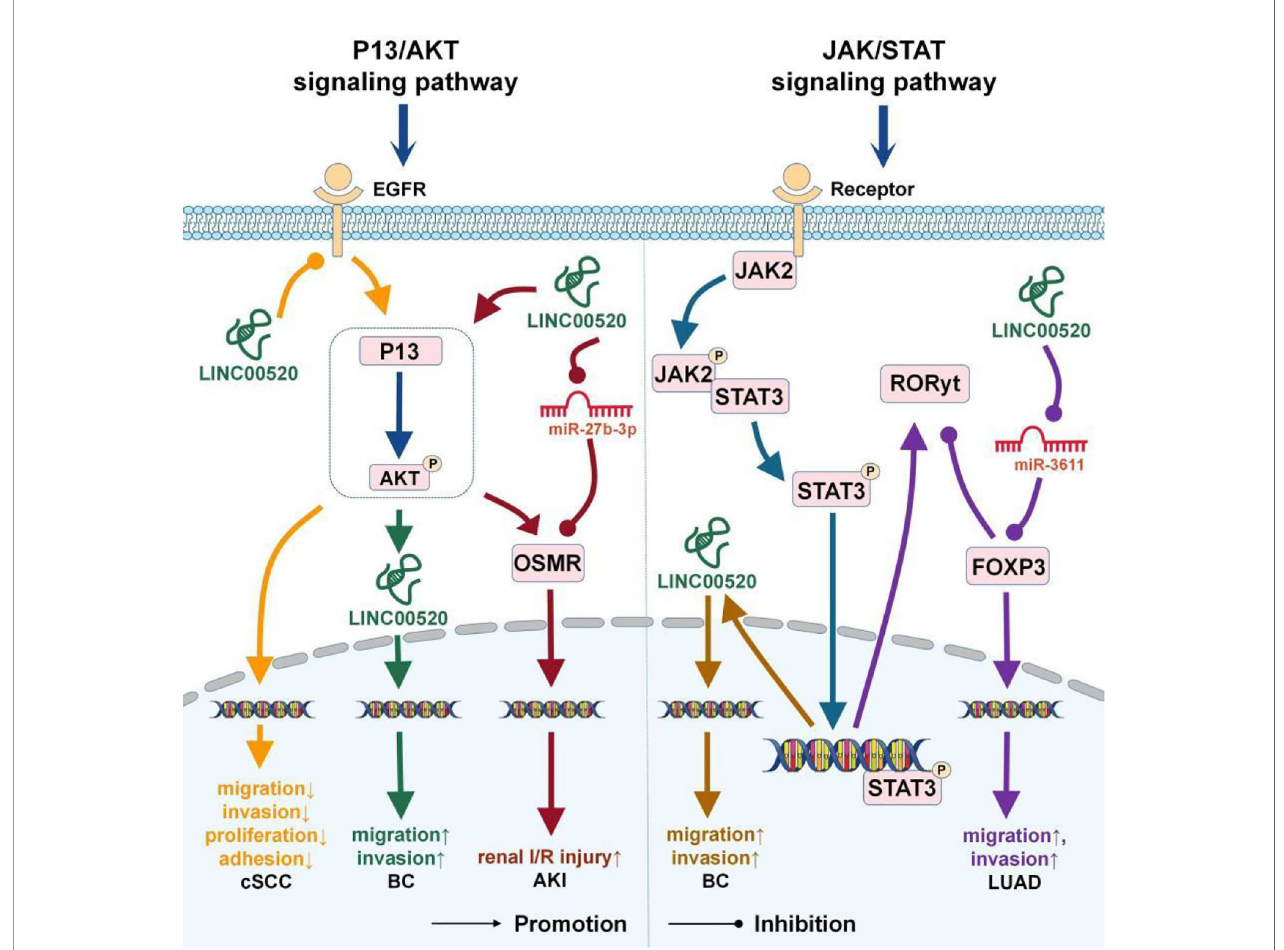
FIGURE 2 | The role of LINC00520 in the P13/AKT and JAK/STAT signaling pathways. BC, breast cancer; cSCC, cutaneous squamous cell carcinoma; LUAD, lung adenocarcinoma; AKI, acute kidney